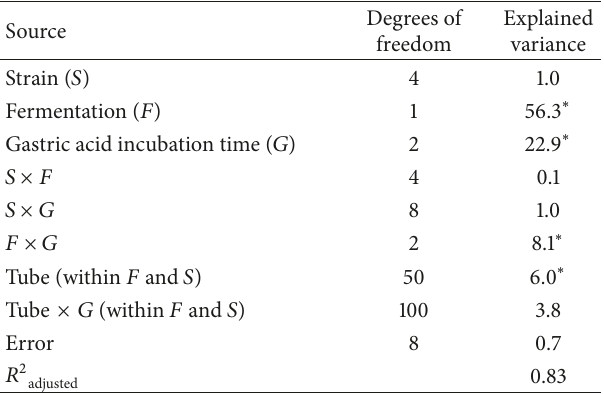
Table 5: ANOVA of E. coli reductions during gastric acid treatment in a TFS model † .